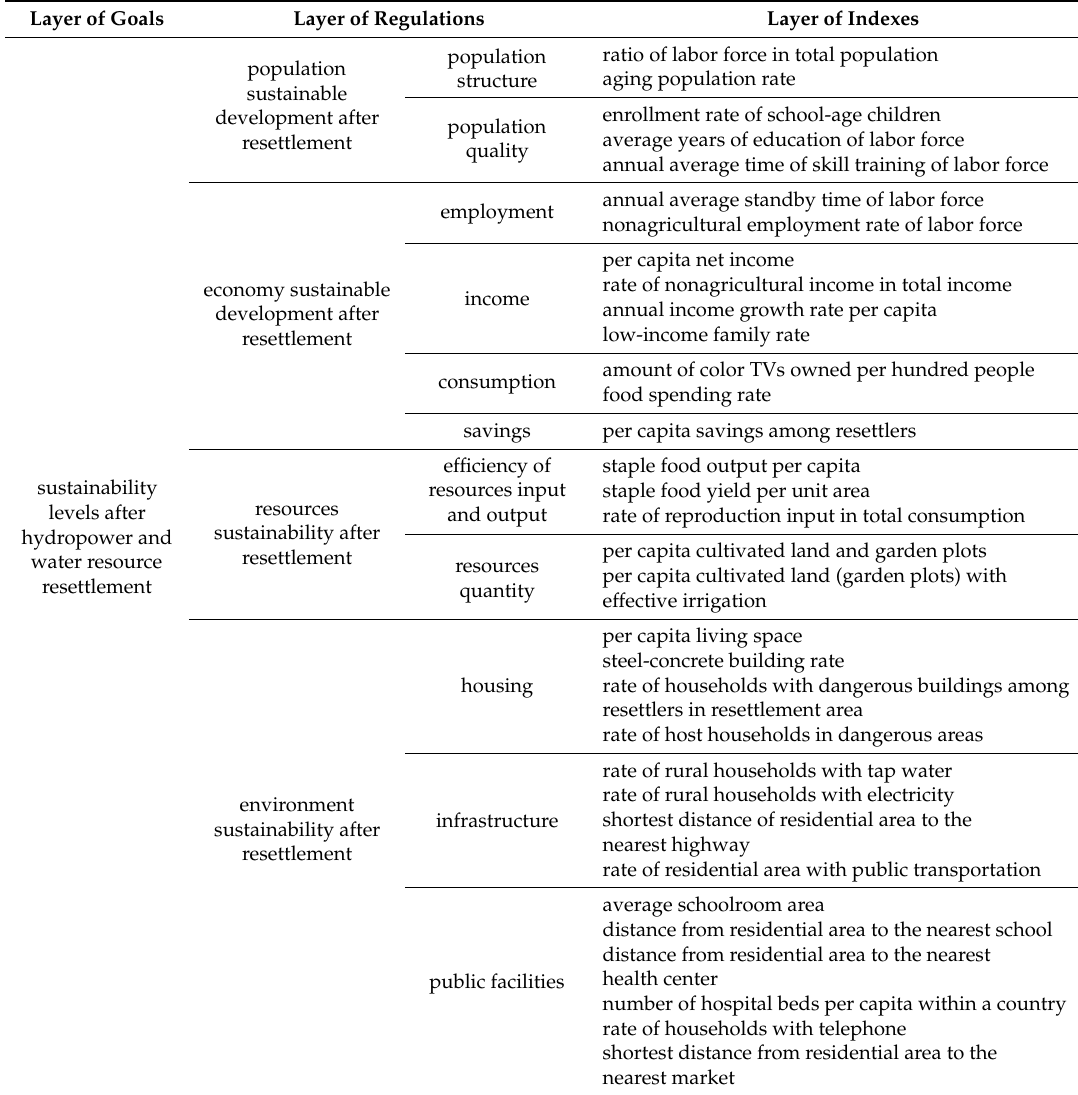
Table 1. Index system of sustainability levels after resettlement in the step hydropower stations along the Wujiang